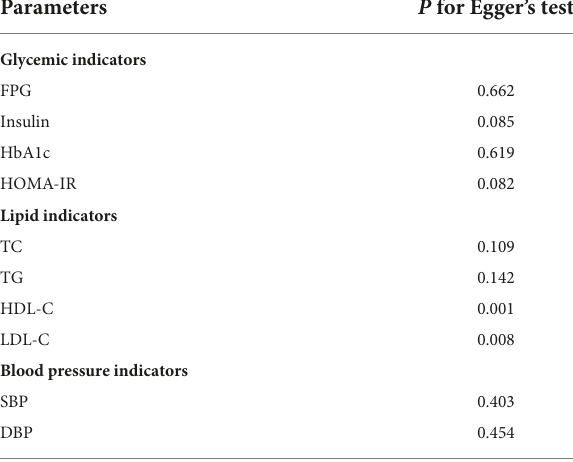
TABLE 3 Publication bias examined by Egger’s linear regression test a .